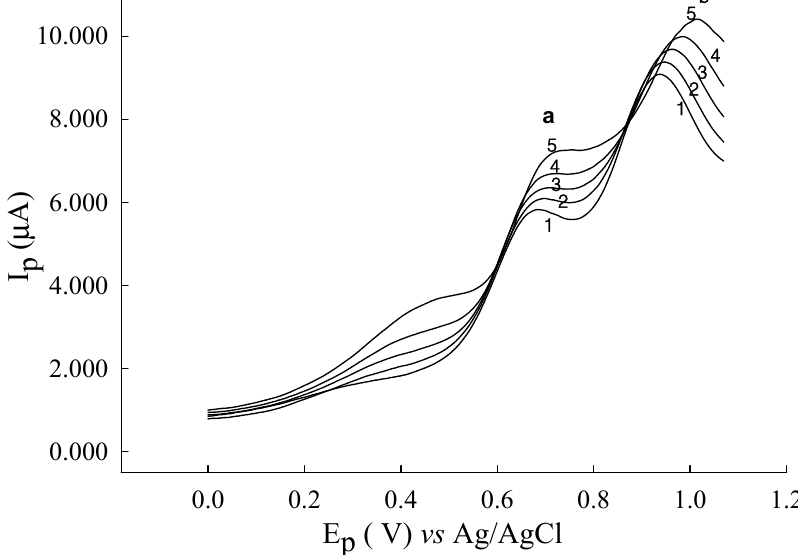
Figure 4. DPV obtained to construction calibration plot for cysteine at an Au/CFE. The peak potential and current values were: (1) with 4 mg·L − 1 of cysteine at a (0.684 V, 5.80 μ A), b (0.939 V, 9.04 μ A); (2) with 8 mg·L − 1 of cysteine at a (0.693 V, 6.07 μ A), b (0.950 V, 9.38 μ A); (3) with 16 mg·L − 1 of cysteine at a (0.696 V, 6.34 μ A), b (0.962 V, 9.68 μ A); (4) with 32 mg·L − 1 of cysteine at a (0.702 V, 6.68 μ A), b (0.985 V, 9.96 μ